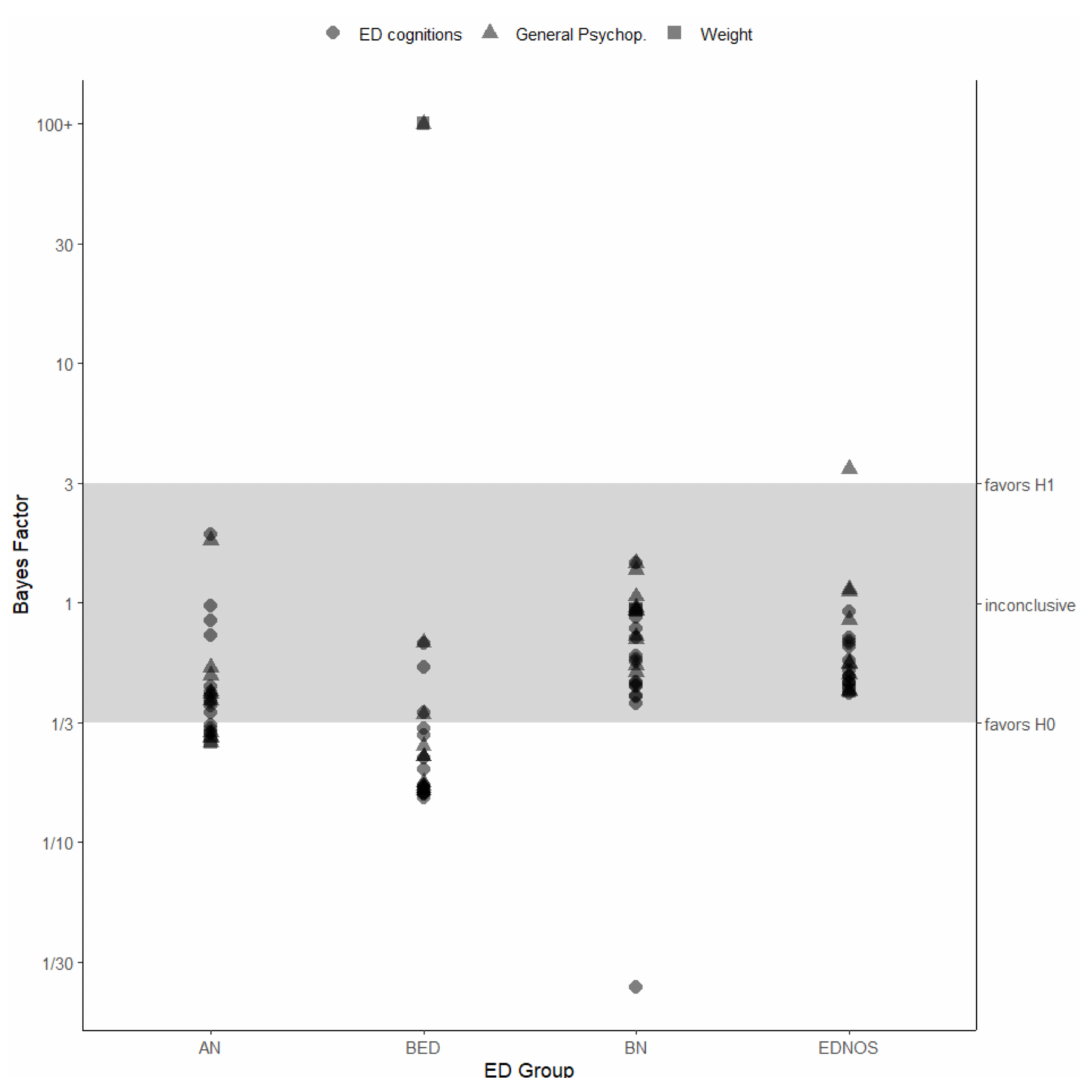
Figure 2. Inclusion Bayes Factor (BF incl ) as an index of evidence strength stratified by ED group and outcome measure category. BF incl ≥ 3 is considered as evidence for H1 (gender modulates the outcome) and, vice versa, a BF incl ≤ 1/3 indicates evidence in favor of the H0 (gender does not modulate the outcome). ED = Eating Disorder, AN = Anorexia Nervosa, BN = Bulimia Nervosa, BED = Binge Eating Disorder, EDNOS = Eating Disorder Not Otherwise